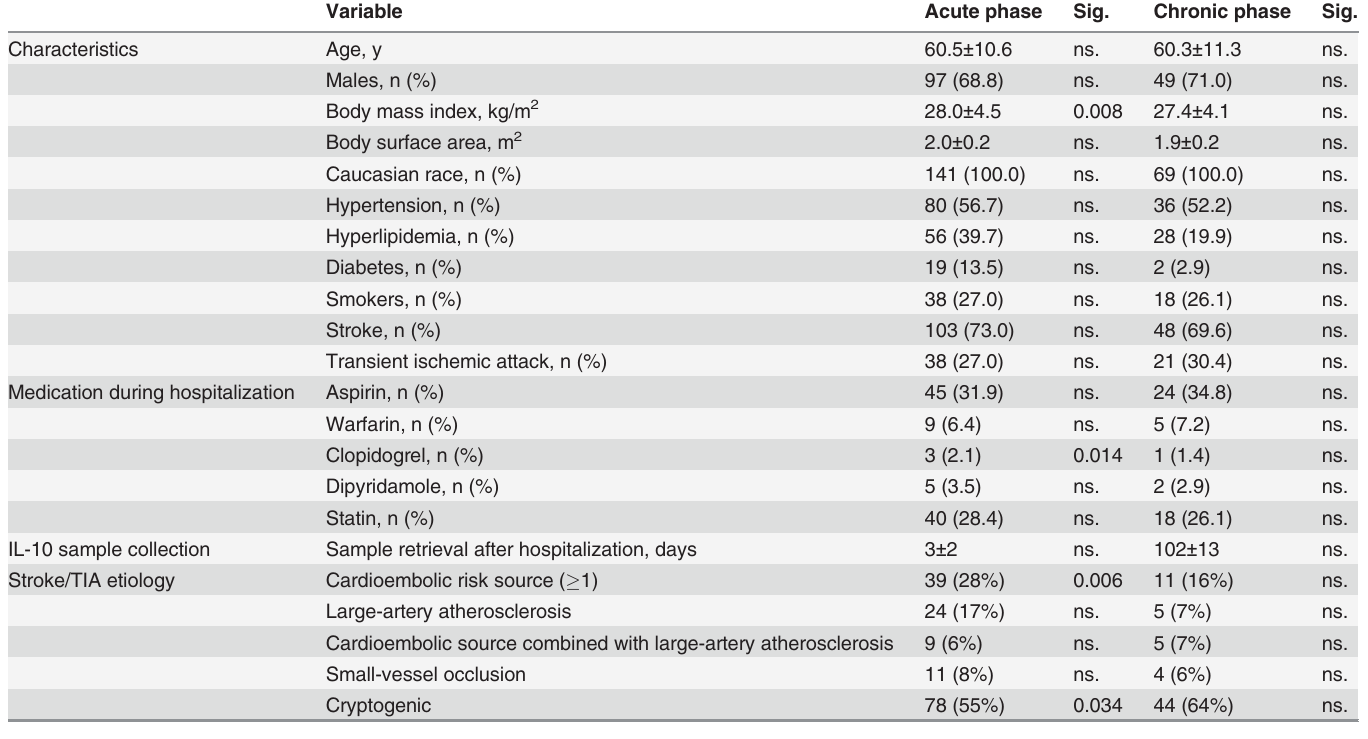
Table 1. The Correlation Between Interleukin(IL)-10 Plasma Concentration and Patient Characteristics of 141 Acute and 69 Chronic Phase Stroke Patients. Variable Acute phase Sig. Sig.